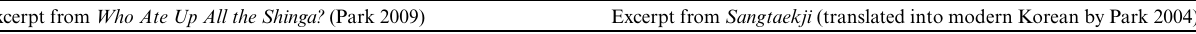
Table 1 . Comparisons of excerpts from Park’s 2009 novel Who Ate Up All the Shinga? and Sangtaekji , a historical Korean reference book, showing similarities in descriptions of landscape components and arrangements in a Korea’s traditional village landscape. Excerpt from Who Ate Up All the Shinga? (Park 2009) Excerpt from Sangtaekji (translated into modern Korean by Park 2004) Our village was nestled between low, gently sloping hills that were free of boulders and commanded an unobstructed view over vast fields. A small river snaked through the broad plains in the center, and brooks were everywhere. ... Even a trip to the outhouse for us meant crossing a little